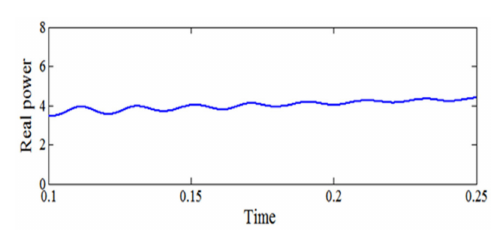
Figure 35. Block diagram of Case IV.